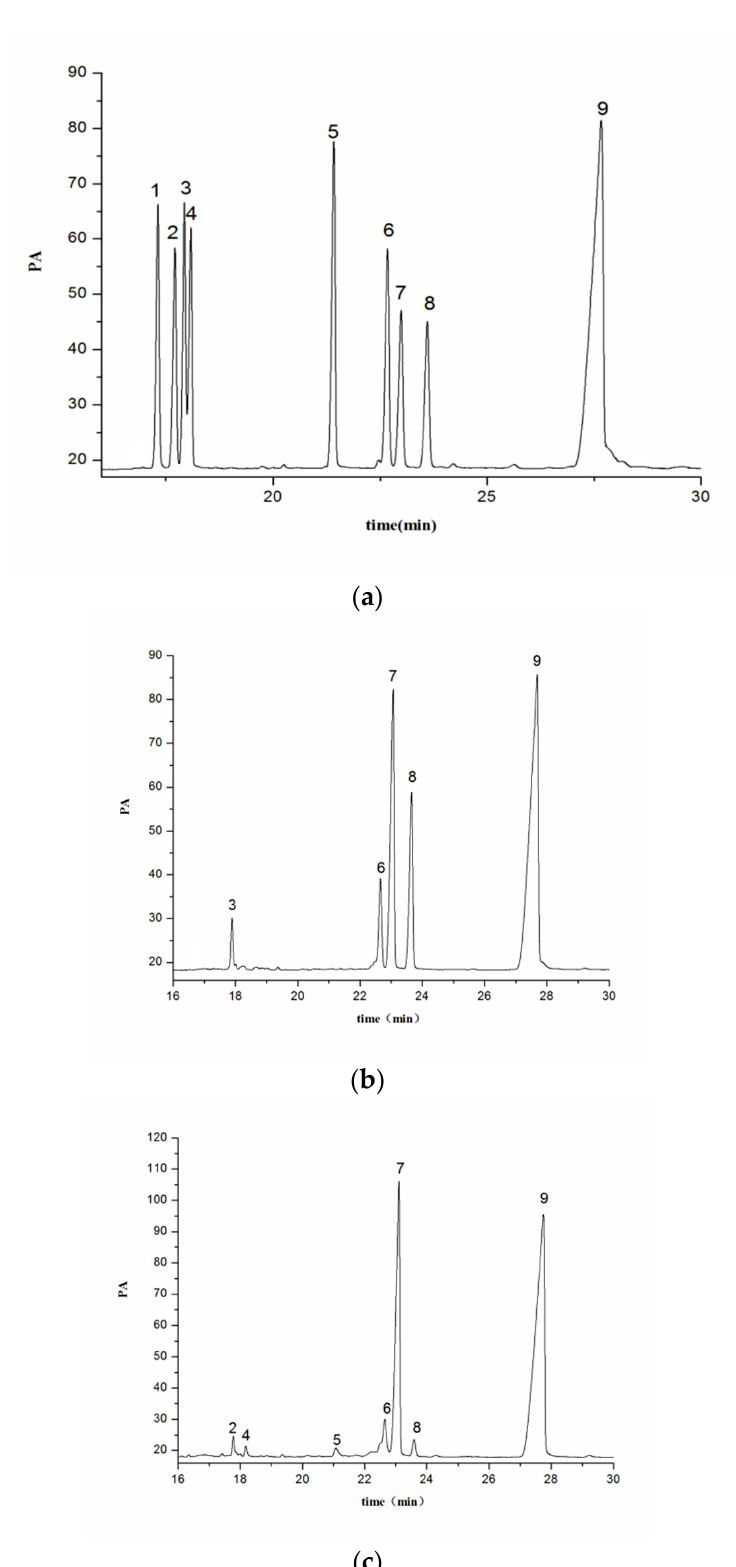
Figure 4. The monosaccharide composition results of ( a ) reference; ( b ) CHFVP-1 and ( c ) CHFVP-2. (1: Rha; 2: Ara; 3: Fuc; 4: Xyl; 5: Ribose; 6: Man; 7: Glc; 8: Gal; 9: internal standard).